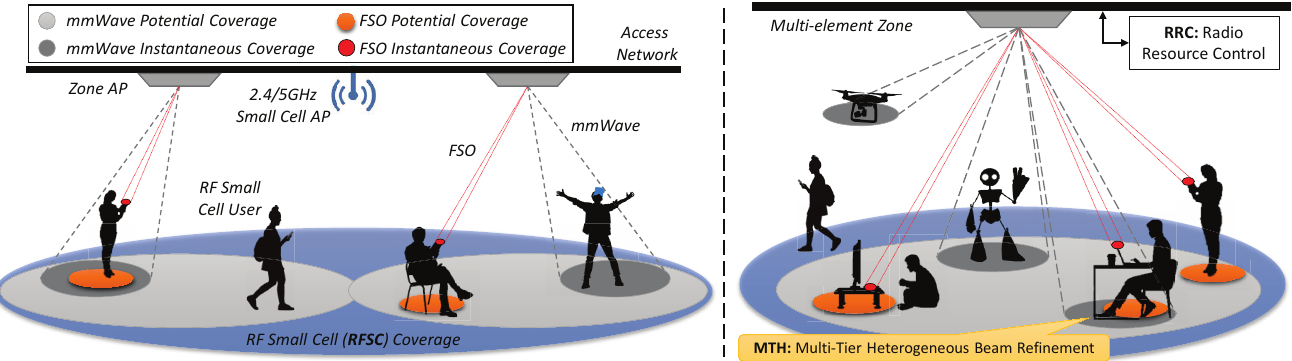
Figure 1. System-level view ( left ); and depiction of a single zone ( right ). Instantaneous coverage is defined as the coverage for a specific orientation/emission configuration (beam width, angle, etc.). Potential coverage is defined as the achievable coverage over all